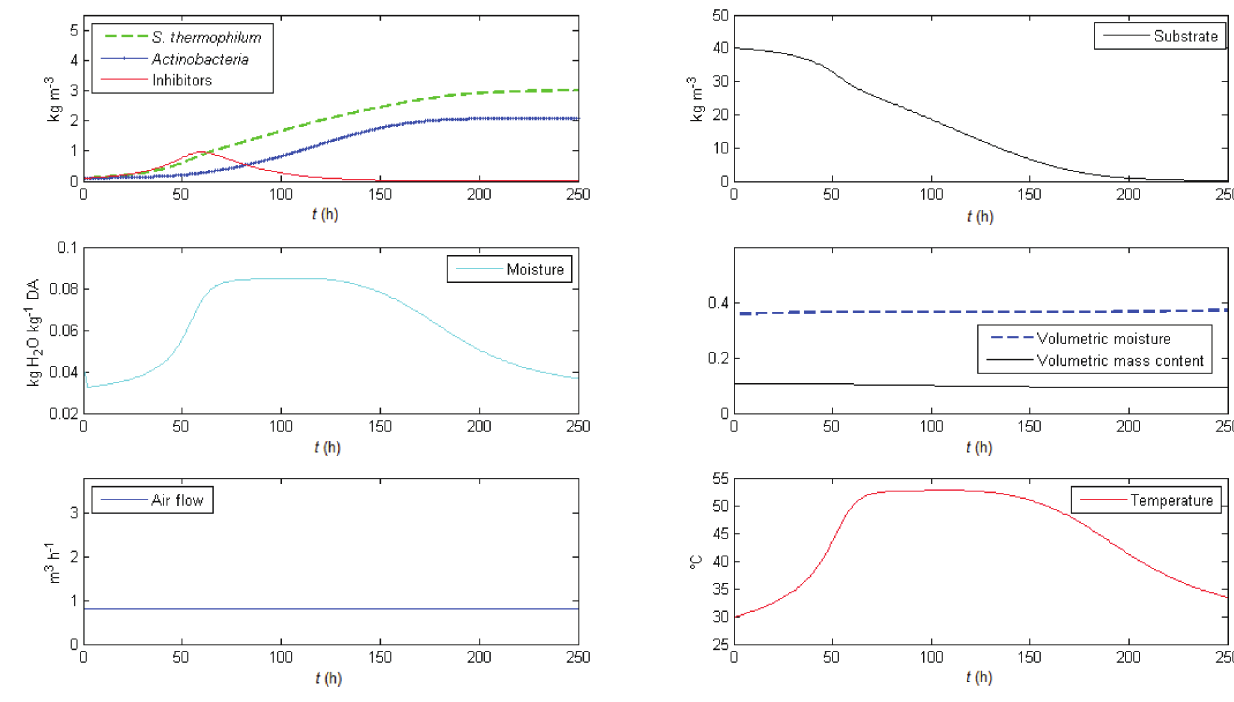
Fig. 3 – SSF Model validation with constant airflow